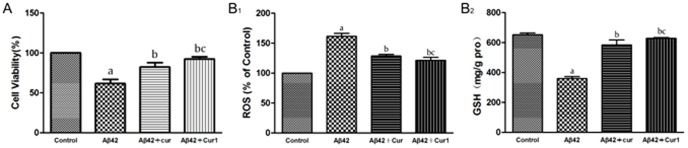
A: MTT assay of cell viability after treatment with curcumin and Cur1. B1: Effects of curcumin and Cur1 on generation of intracellular ROS. After damage by Aβ1-42, intracellular ROS increased as determined by evaluation of DCF fluorescence. The increase in ROS was inhibited by the presence of curcumin and Cur1. B2: Effects of curcumin and Cur1 on GSH, a sensitive indicator of oxidative stress. Curcumin and Cur1 both increased the expression of GSH in SK-N-SH cells. Results are represented as mean ± SD from five independent experiments. a: P<0.001 vs. control group. b: P<0.001 vs. Aβ1-42 group. c: P<0.01 vs. curcumin group.